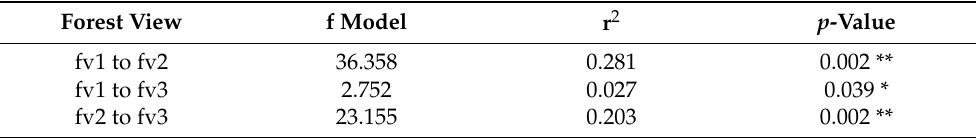
Table 4. Results of the pairwise permutation tests for the three different forest views (fv1 to